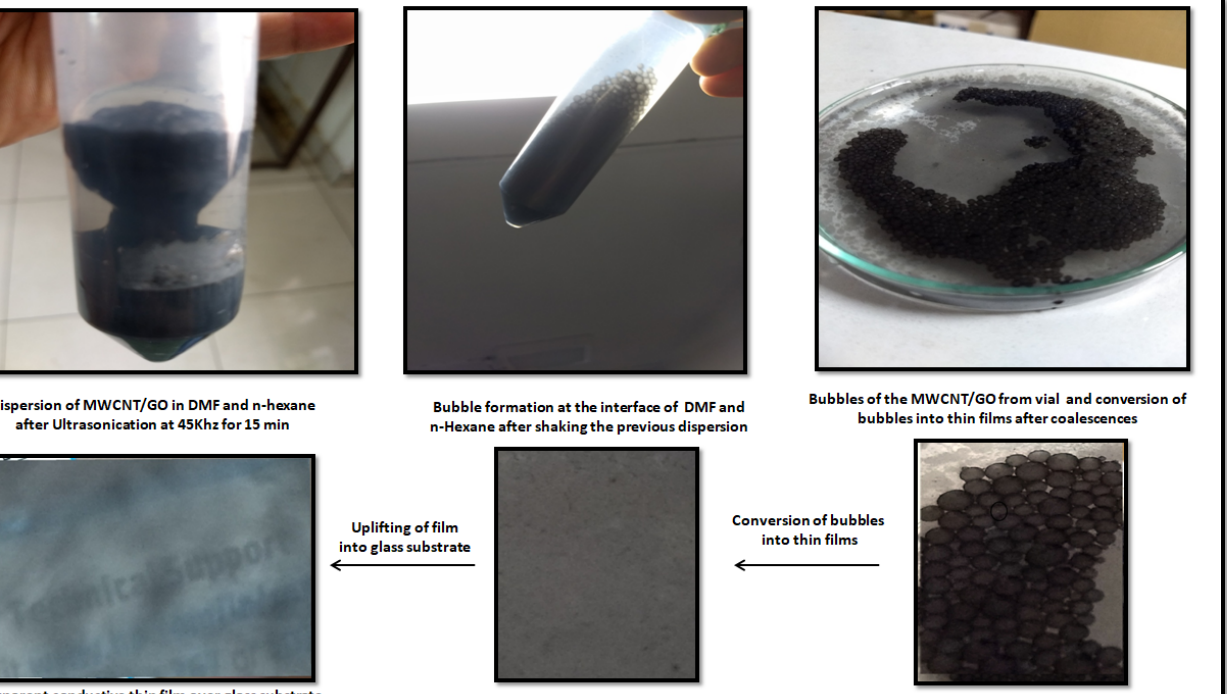
Figure 12. Optical image of the thin film of MWCNT/GO nanohybrid with a section view of the varying thickness of the film.